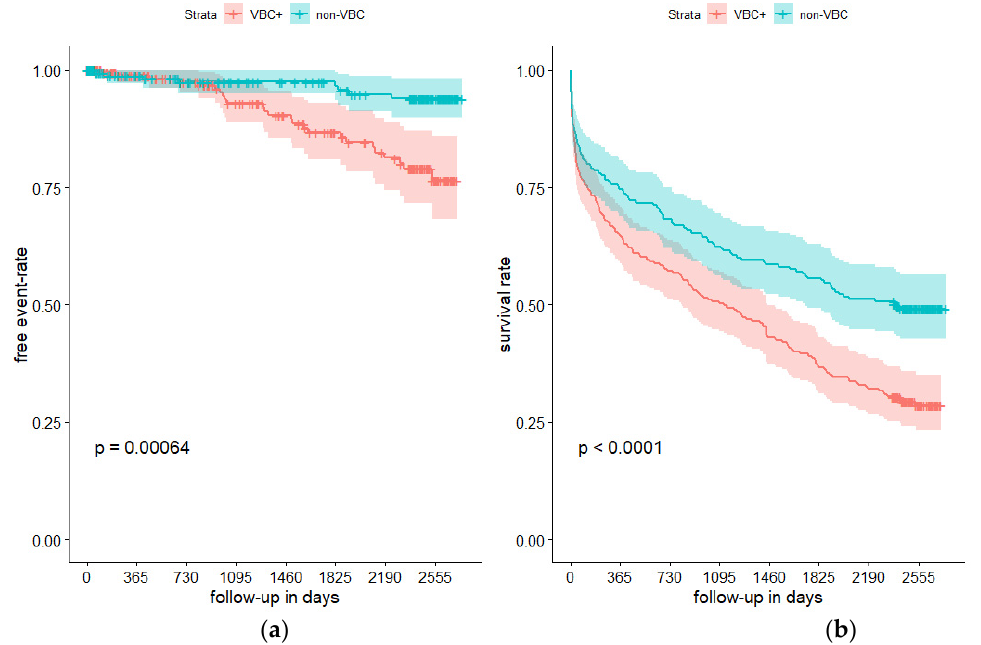
Figure 2. Survival analysis using Kaplan–Meier method of the presence of recurrent stroke (( a ) Panel A) and death (( b ) Panel B) during 7 years in the population of 448 patients with ischemic strokes according to presence of arterial calcifications in intracranial vertebral arteries and/or basilar artery. Vertical lines represent censored data. VBC+: vertebrobasilar calcifications present. Crosses represent censored (died and lost to follow-up) data.